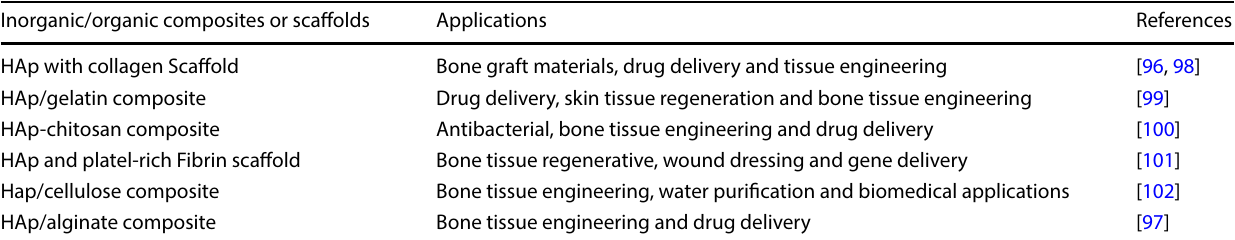
Table 7 Scaffolds for biomedical uses Inorganic/organic composites or scaffolds Applications